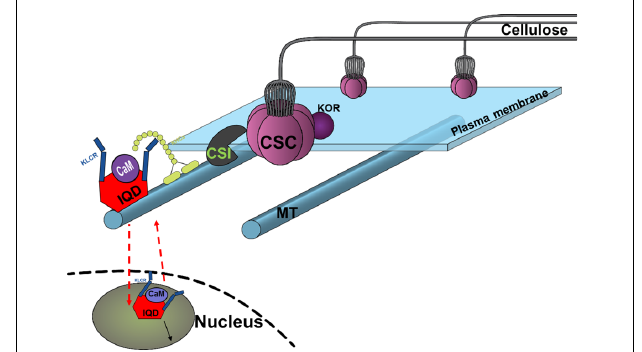
FIGURE 11 | Conceptual model of proposed functional role of PdIQD10 in cell wall biosynthesis pathway at both its plasma membrane and nucleus (nuclear region) locations. The conceptual localization of PdIQD10 on microtubules (MT) is based on similar studies in Arabidopsis and not undertaken or evidenced in the present study of Populus